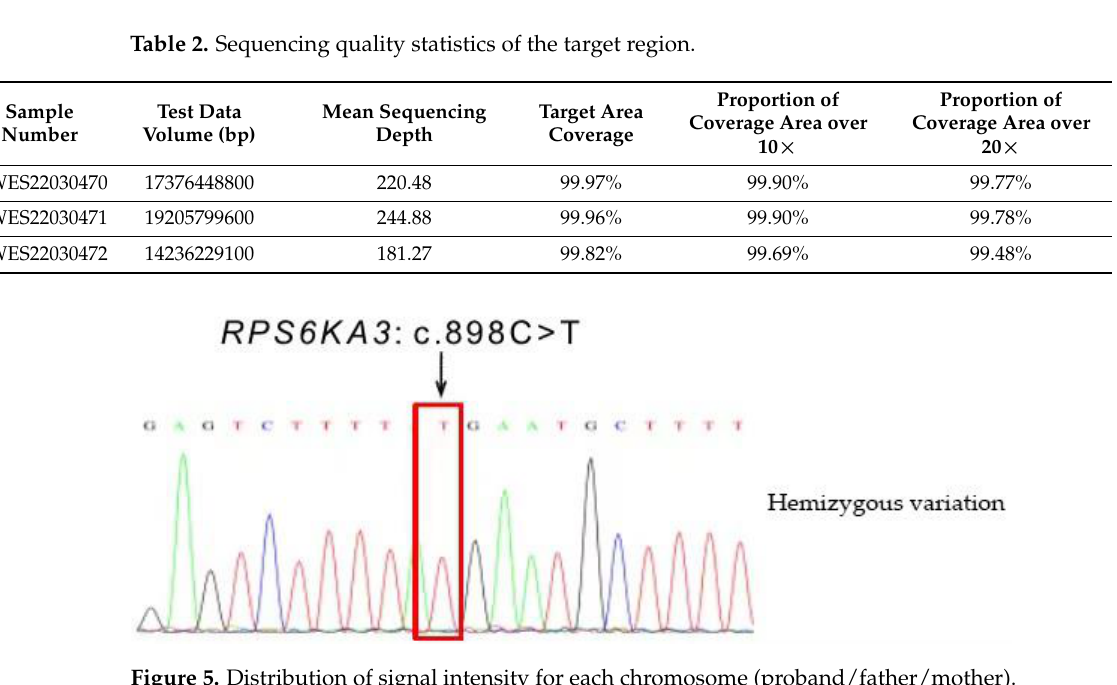
Figure 5. Distribution of signal intensity for each chromosome (proband/father/mother).